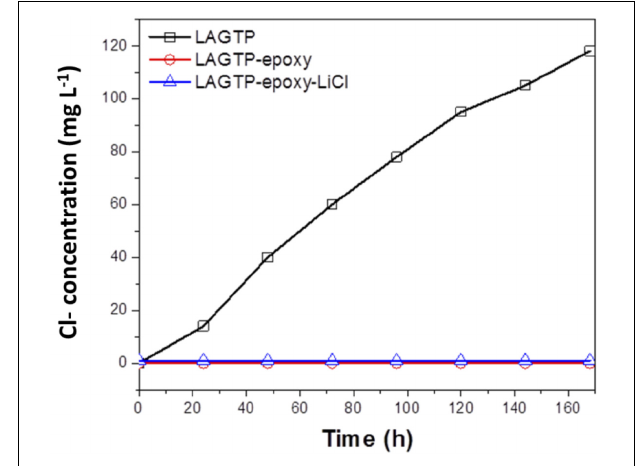
FIGURE 5 | Electrical conductivity of LAGTP-E-LiCl as a function of temperature.